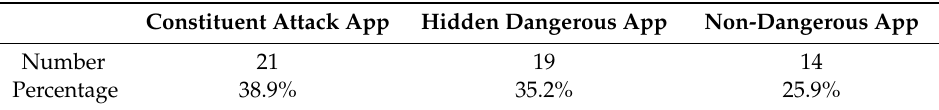
Table 9. App attack classification.